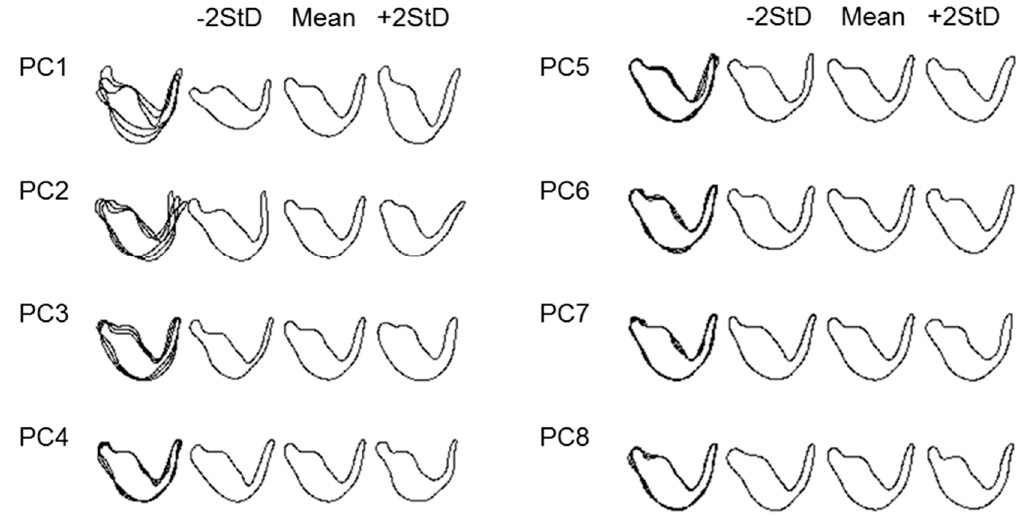
Figure 3. Elliptic Fourier Analysis of the dorsal view of the left paramere outlines. Reconstructions of outlines using the inverse Fourier transform based on the mean value, and the mean ± 2 s.d. of each of the first eight PCs. Overlapping lines in the first column denote areas of paramere variation.